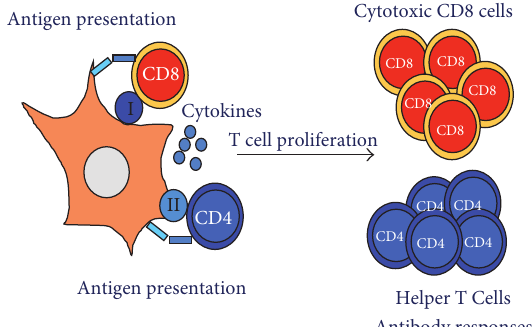
F 4: Antigen presentation and T cell responses.